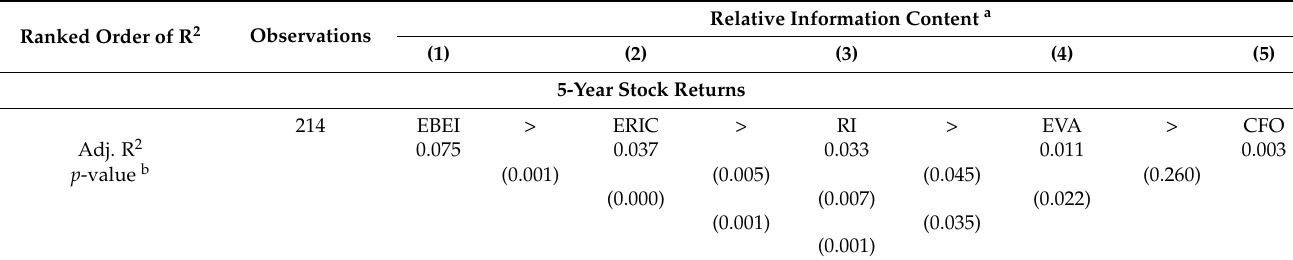
Table 6. Tests of relative information content of CFO, EBEI, RI, EVA, and ERIC predicting 5-year stock